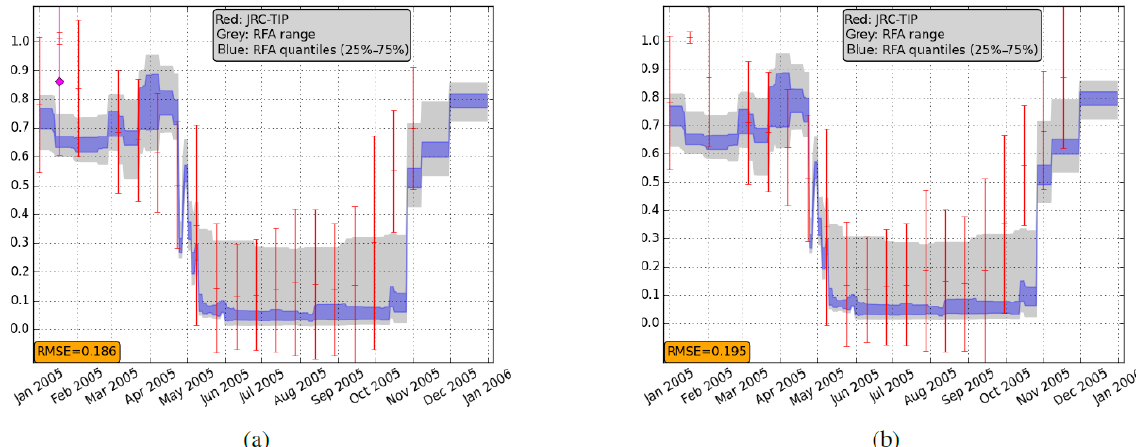
Figure 8. Comparison of the fraction of solar radiation transmitted to the background as derived by JRC-TIP applied to MODIS collection 5 input albedos and as observed in situ over the Hainich deciduous forest site following the approach by Pinty et al. (2011c). Panel (a) is based on 500m MCD43 input albedos and panel (b) is based on the MCD43 1km albedo product. The shaded zones indicate the range (grey) and interquartile (blue) range both estimated from the collected in situ measurements (using a LAI-2000 Plant Canopy Analyzer) from 2002 to 2008 along a 400m transect using the so-called random forest algorithm (RFA). Panel (a) also shows, in the colour magenta, a second retrieval for the period from the middle to the end of January using the snow